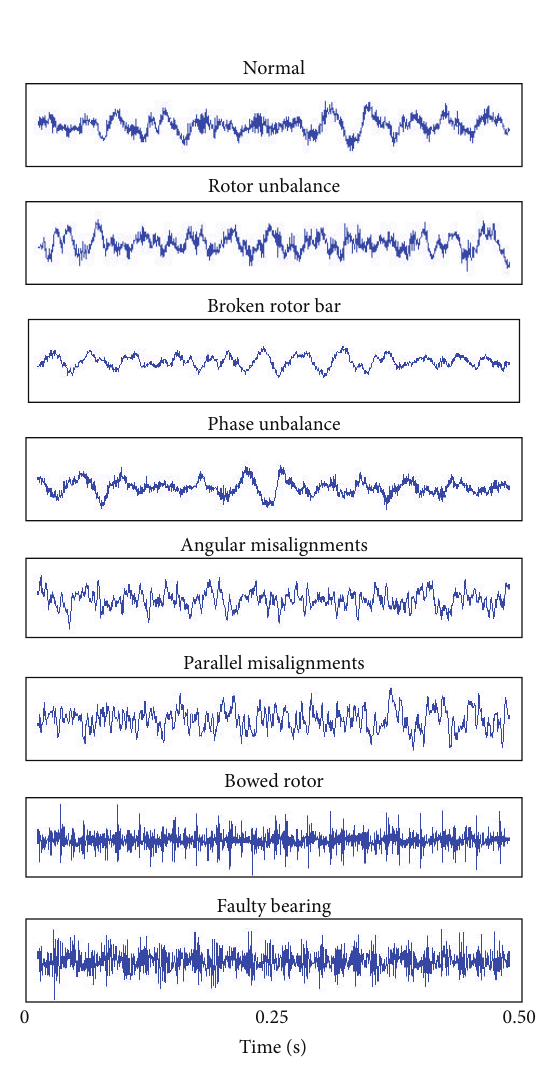
Figure 6: The representative vibration waveforms of the induction motor